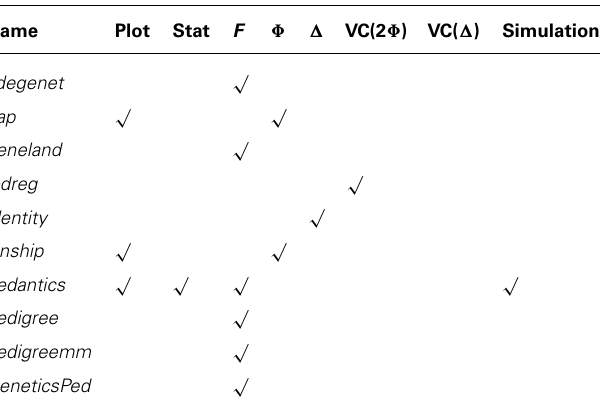
Table 1 | R packages available for pedigree